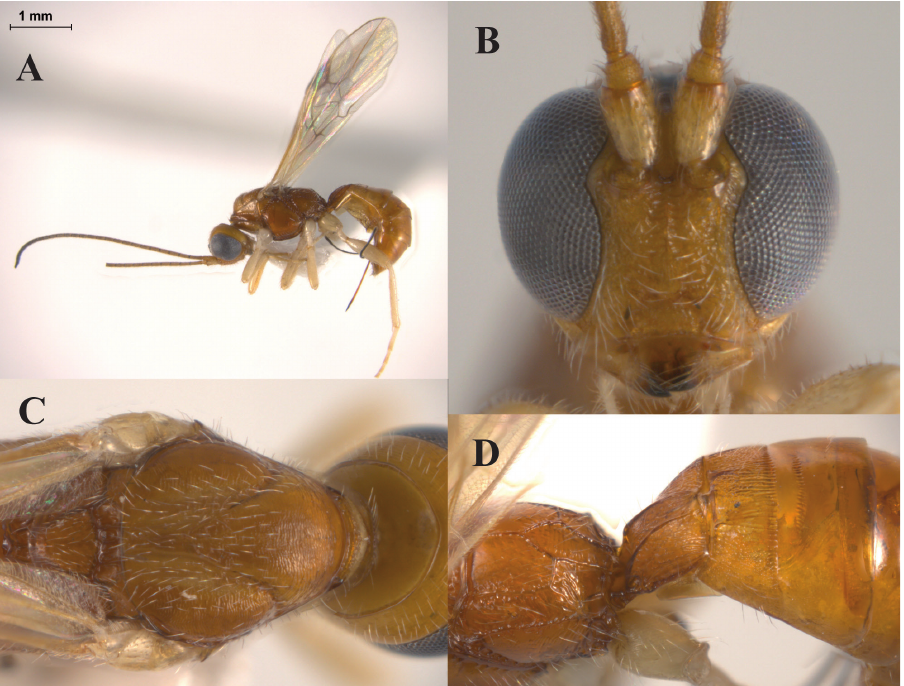
Figure 3. Heerz macrophthalma sp. n. (holotype): A habitus, lateral view B head, frontal view C meso- soma, dorsal view D propodeum and basal half of mesosoma, dorsolateral